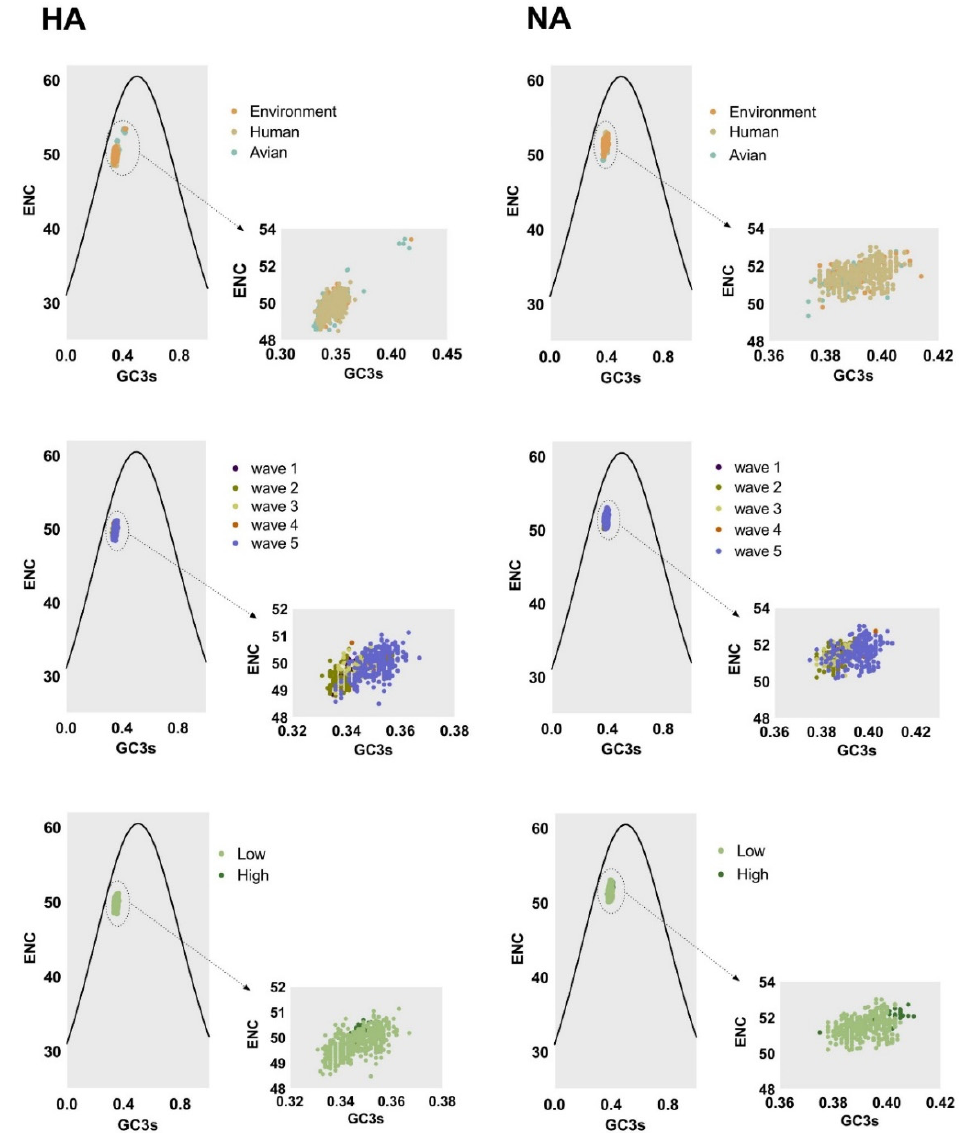
Figure 4. Left column and right column of ENC-plot analysis represent the HA and NA genes, respectively. The environment, human, and avian are represented in orange, beige, and cyan, respectively. Dark purple, olive green, light yellow, orange, and light purple correspond to waves 1 to 5, respectively. Grass green corresponds to high pathogenicity.